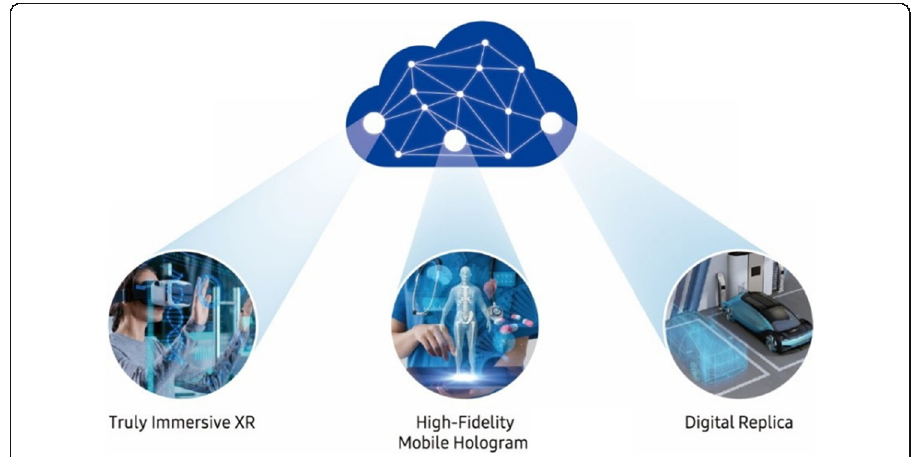
Fig. 12 Hologram technology (Samsung White Paper,